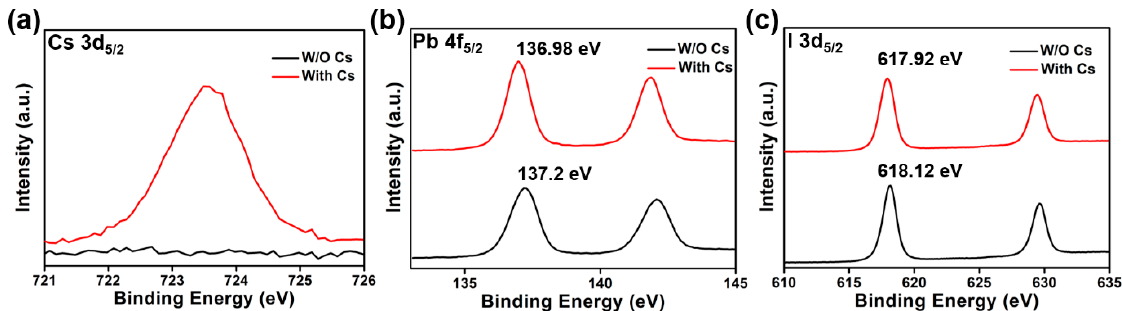
Figure 5. X-ray photoelectron spectroscopy (XPS) results for perovskite films without and with 5% cesium doping: ( a ) Cs 3d 5/2 , ( b ) Pb 4f 5/2 , and ( c ) I 3d 5/2 .